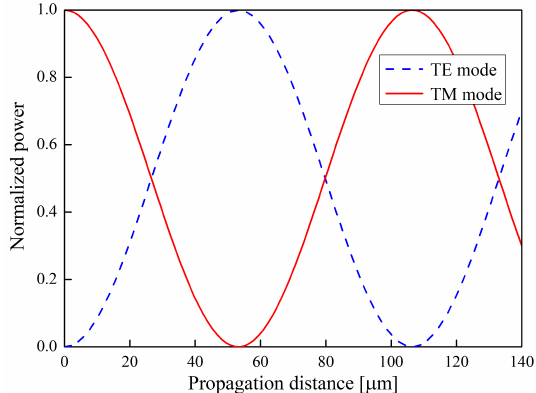
Figure 6. Normalized power variation of the TM mode incident light against the propagation